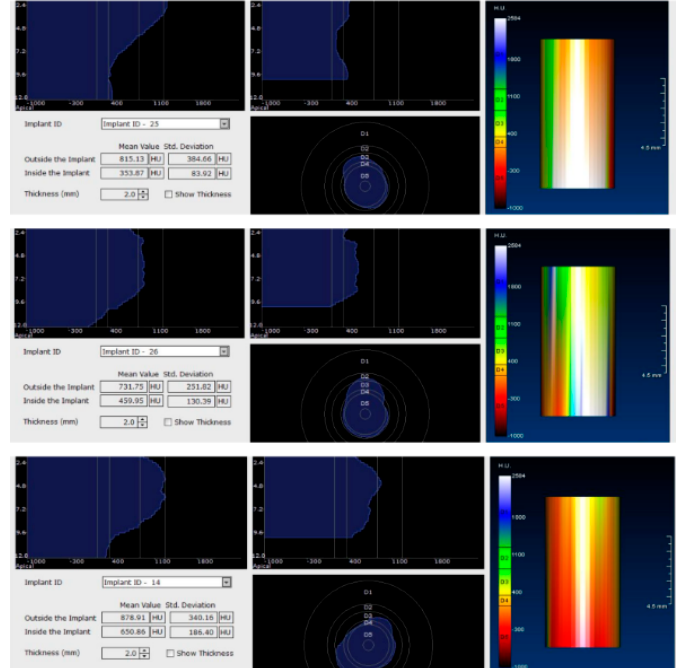
Figure 12. Bone density around dental implants at 60 days following surgery with conventional healing caps.